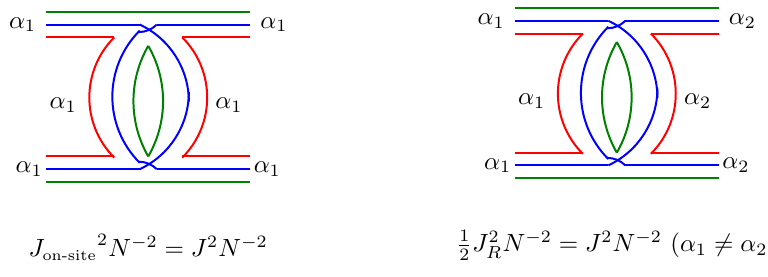
Figure 8. Contribution of interactions to dipole of green